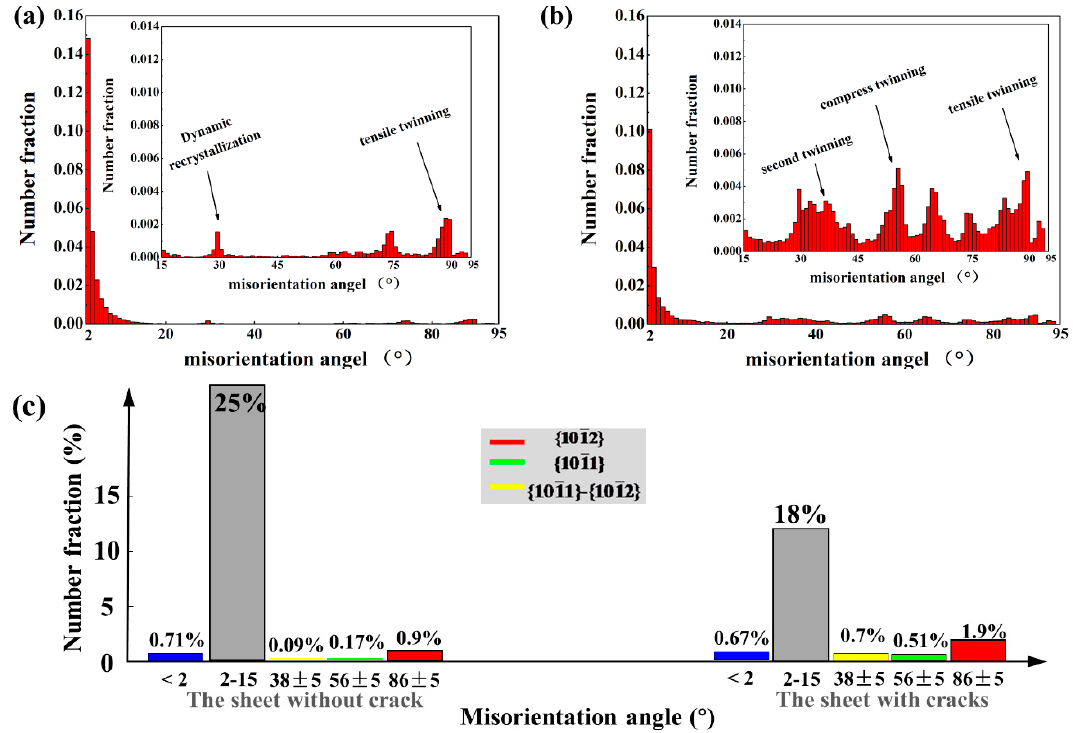
Figure 9. Misorientation angle of ( a ) the sheet with cracks and ( b ) the sheet without cracks. ( c ) Comparison of contents of sub-grain boundaries and other three kinds of twin boundaries.